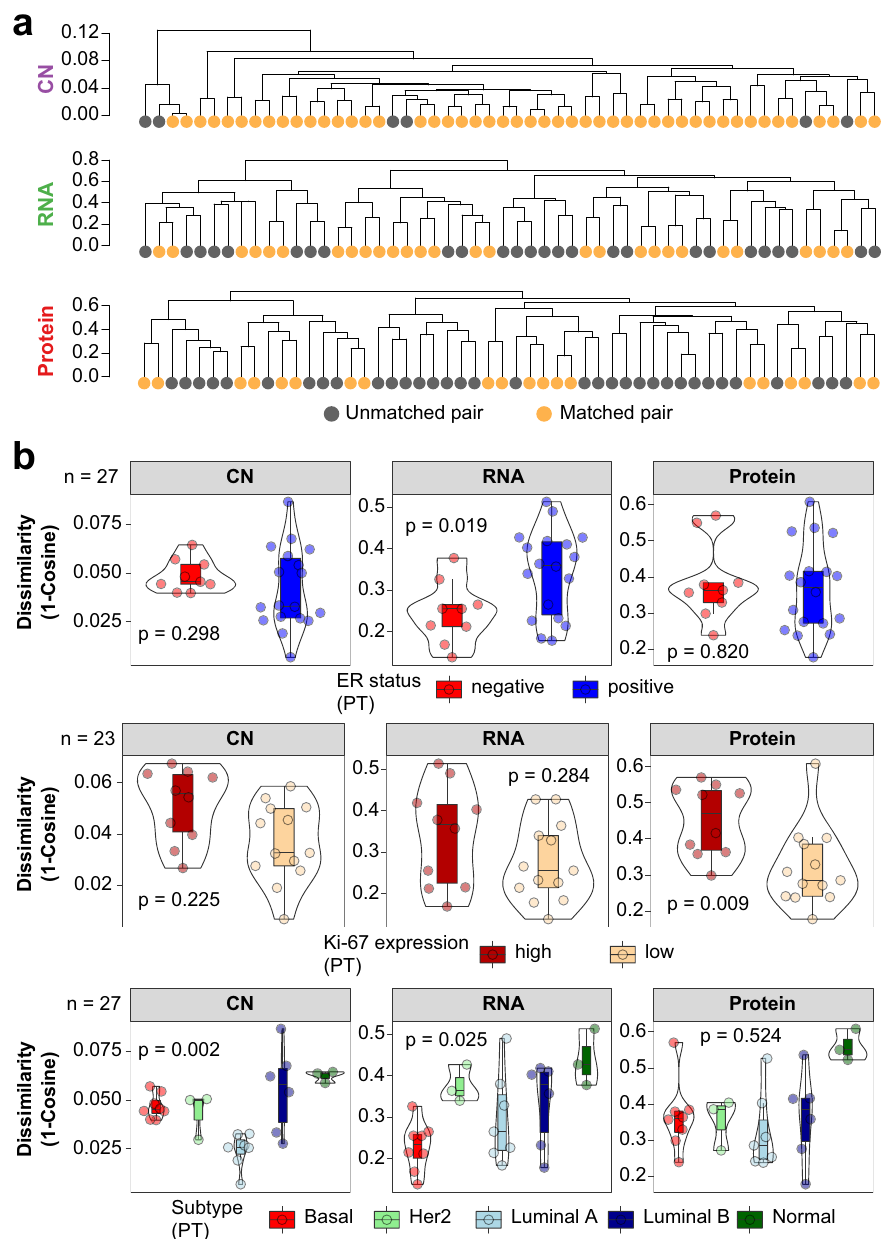
Fig. 4 Multi-omic drift assessment of breast cancer recurrences. Cosine dissimilarities (i.e., 1-Cosine similarity) were calculated between tumor pairs at the CN, transcript, and protein levels as a measure of evolutionary drift. a PT-IBTR dissimilarity-based clustering at the CN, transcriptome, and protein levels. b Association between clinical variables and PT-IBTR dissimilarity across data layers. Number of samples included in each test depends on availability of clinical data. Boxplots depict distribution of values as quartiles. Line at the center of each boxplot depict the median value. CN copy number, ER estrogen receptor, IBTR ipsilateral breast tumor recurrence, PgR progesterone receptor, PT primary tumor, SNV single nucleotide variant, TP53 tumor protein